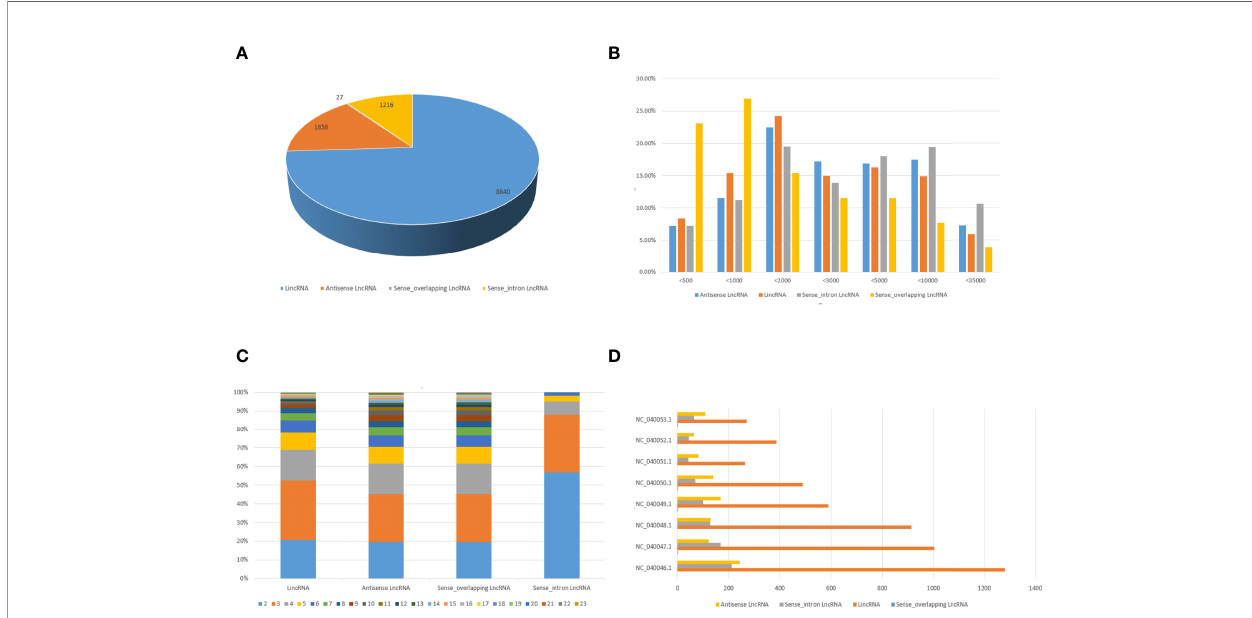
FIGURE 3 | Characteristics of duck lncRNAs. (A) The number of lincRNAs, intronic lncRNAs, sense overlapping lncRNA, and antisense lncRNAs in DEFs. (B) Transcript length distribution of different categories of lncRNAs. (C) Analysis of exons numbers for different categories of LncRNAs. (D) Distribution of different categories of lncRNAs on different chromosomes.